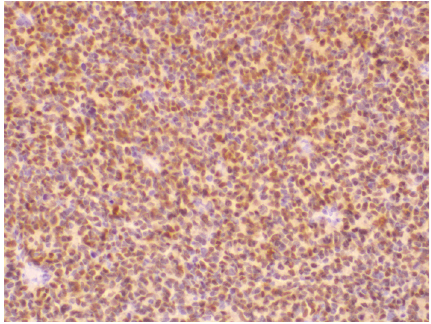
Figure 9: Immunohistochemistry shows positive cytoplasmic (dot- like) staining of the tumor cells for desmin (X200).